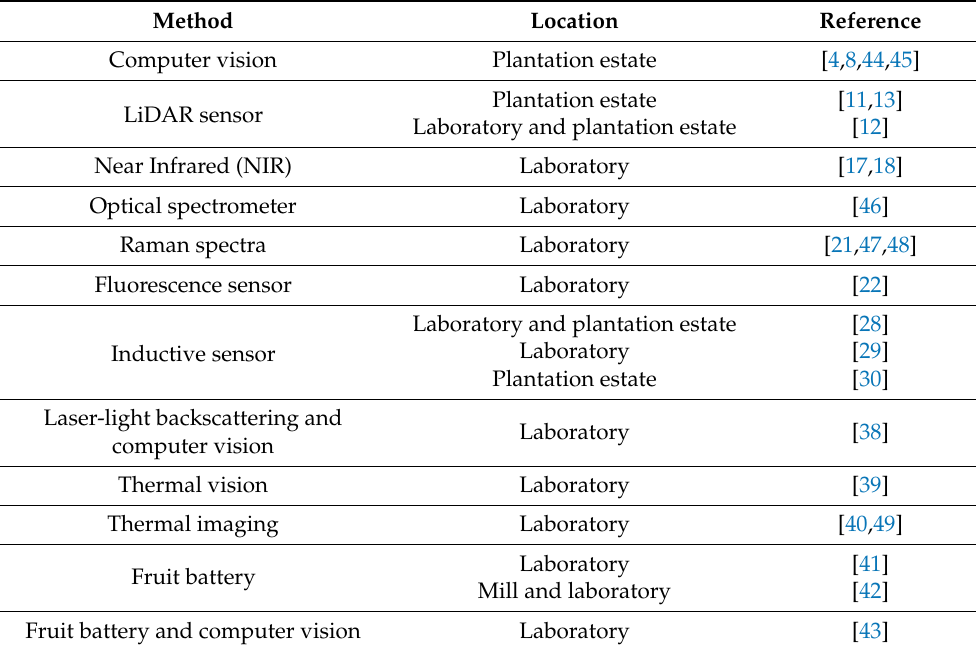
Table 3. Location of method implemented on classification FBB